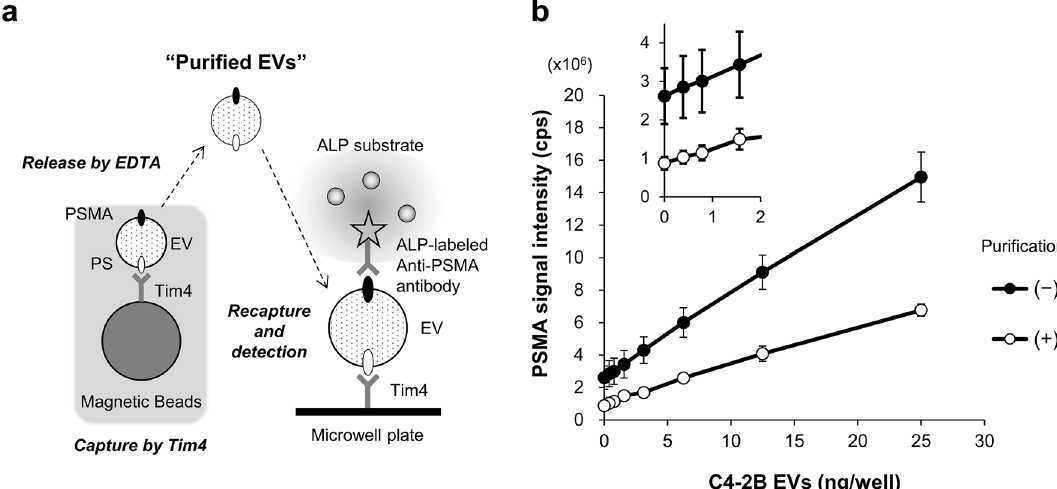
Figure 4. Comparison of the plate-based PSMA-EV sandwich ELISA with and without purification of EVs from serum. ( a ) Schematic diagram of the preparation of “purified EVs” by Tim4 and the measurement of the PSMA levels on EVs recaptured by Tim4 immobilized on the microplate. ( b ) Serum containing increasing doses of C4-2B EVs was prepared for each normal donor (n = 5). The serum containing C4-2B EVs was incubated with Tim4-bound magnetic beads and then EVs were released from Tim4 by adding EDTA. Serum containing increasing doses of C4-2B EVs (50 µL, filled circle) or EVs purified from the same amount of the serum (open circle) were transferred to a well of 96-well plate where they were recaptured by immobilized Tim4, followed by detection of PSMA on EVs. When PSMA-EVs in serum containing C4-2B EVs was measured, EV binding to Tim4 was conducted at its final concentration of 50%. Inset: Enlarged plot at low concentrations. Data are shown by mean ± SD and those for each donor is presented in Supplementary Fig.